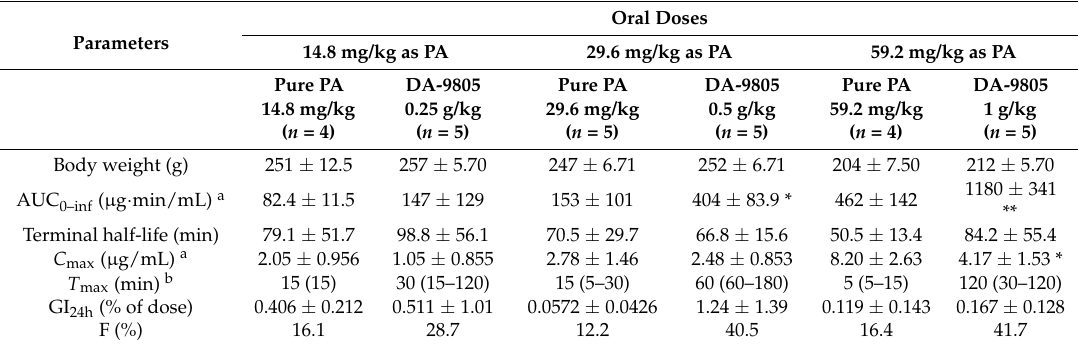
Table 3. Pharmacokinetic parameters of PA after oral administration of pure PA or DA-9805 at doses equivalent to 14.8, 29.6, and 59.2 mg/kg of PA to rats (mean ± SD).